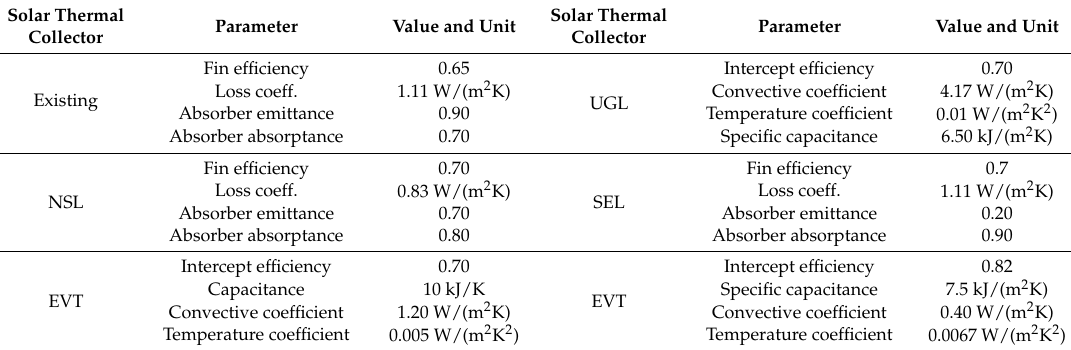
Table 3. Main parameters of the solar collectors.